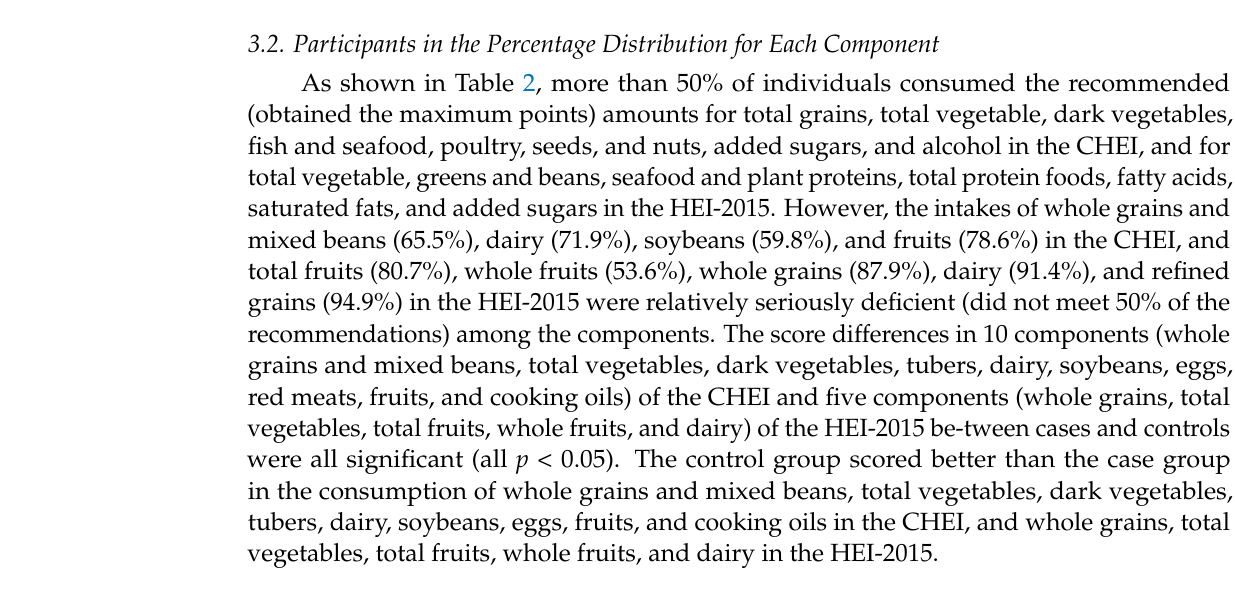
Table 2. Comparison of the percentage distribution of the cases and controls according to the scores on each item in the CHEI and